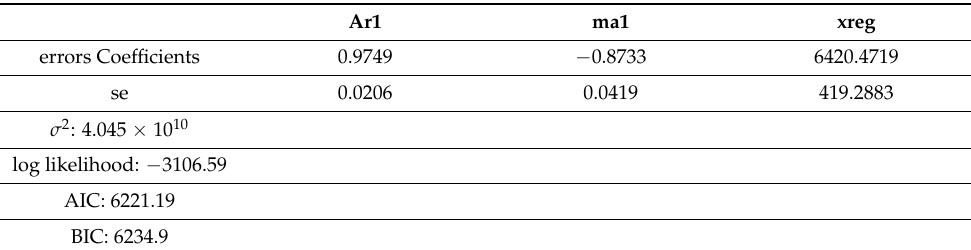
Table 4. Deterministic model (Regression with ARIMA (1,0,1).